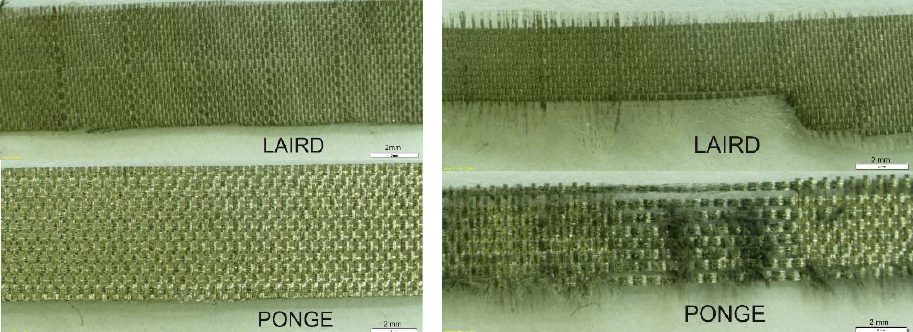
Figure 12. An example of the view of the Ponge and Laird strips before (on the left) and after (on the right) 2000 rubbing cycles (white scale bar = 2mm).